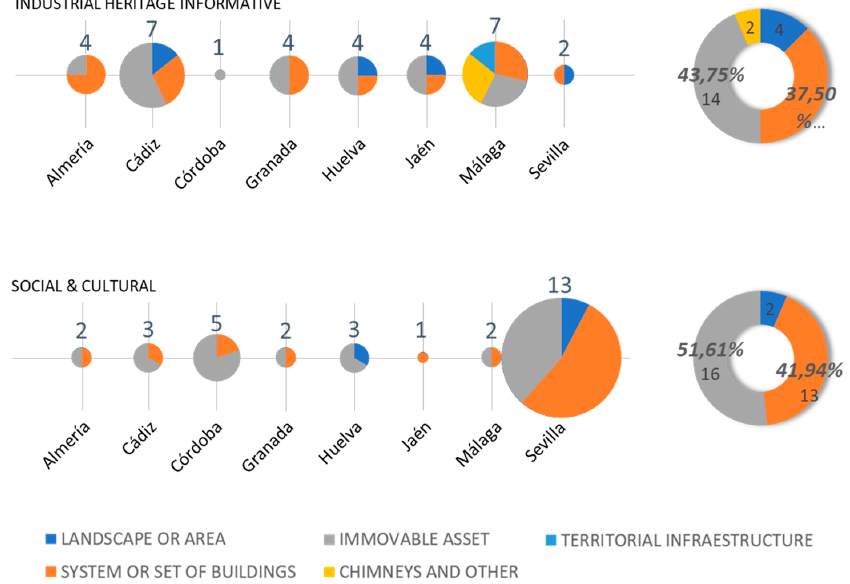
Figure 11. Distribution of assets within the two new uses with the highest number of assets and also considering the location and the scale